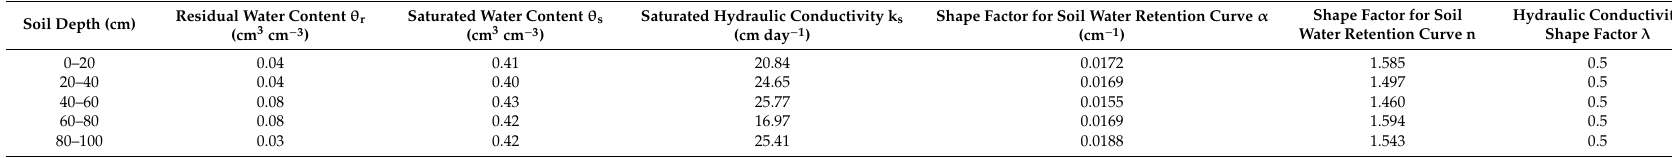
Table 5. Calibrated soil hydraulic parameters in van GenuchtenMualem (VGM) model.